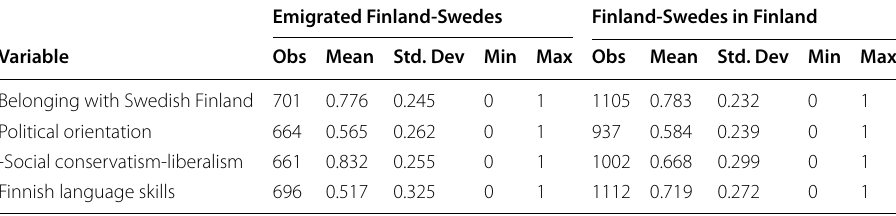
Table 2 Descriptive statistics for independent